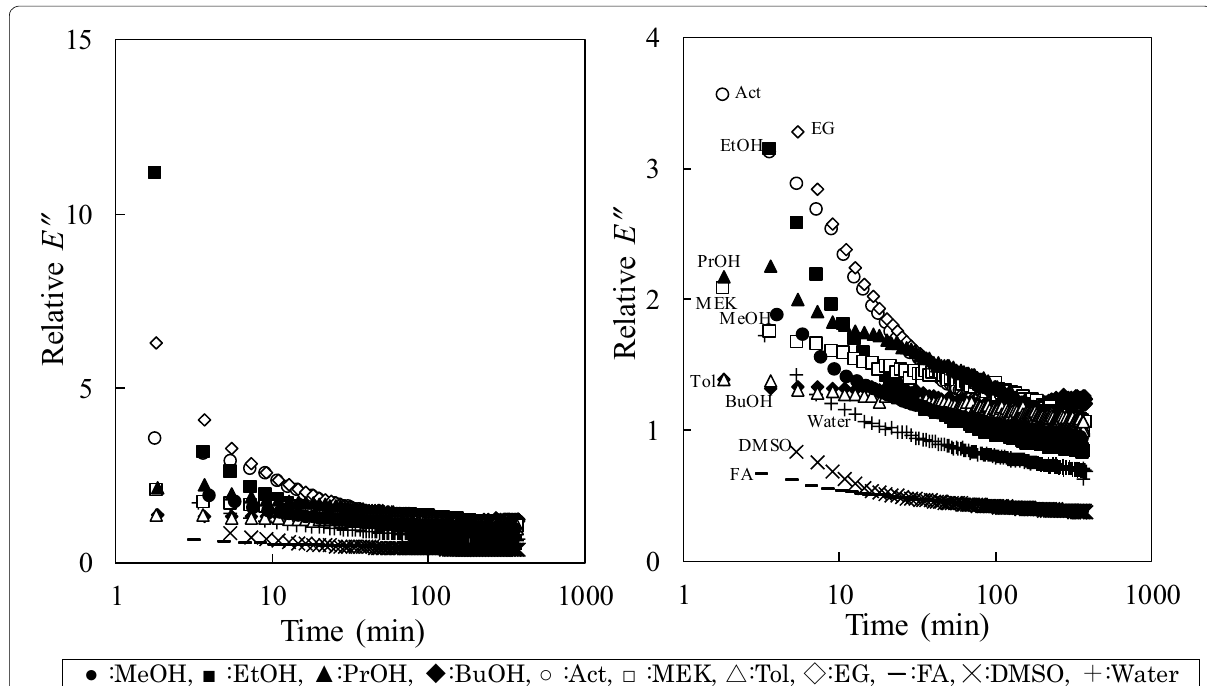
Fig. 8 Change in the relative E ʺ of the untreated sample after soaking in water or each organic liquid. The relative E ʺ was relative to the value for the untreated sample in oven‑dried